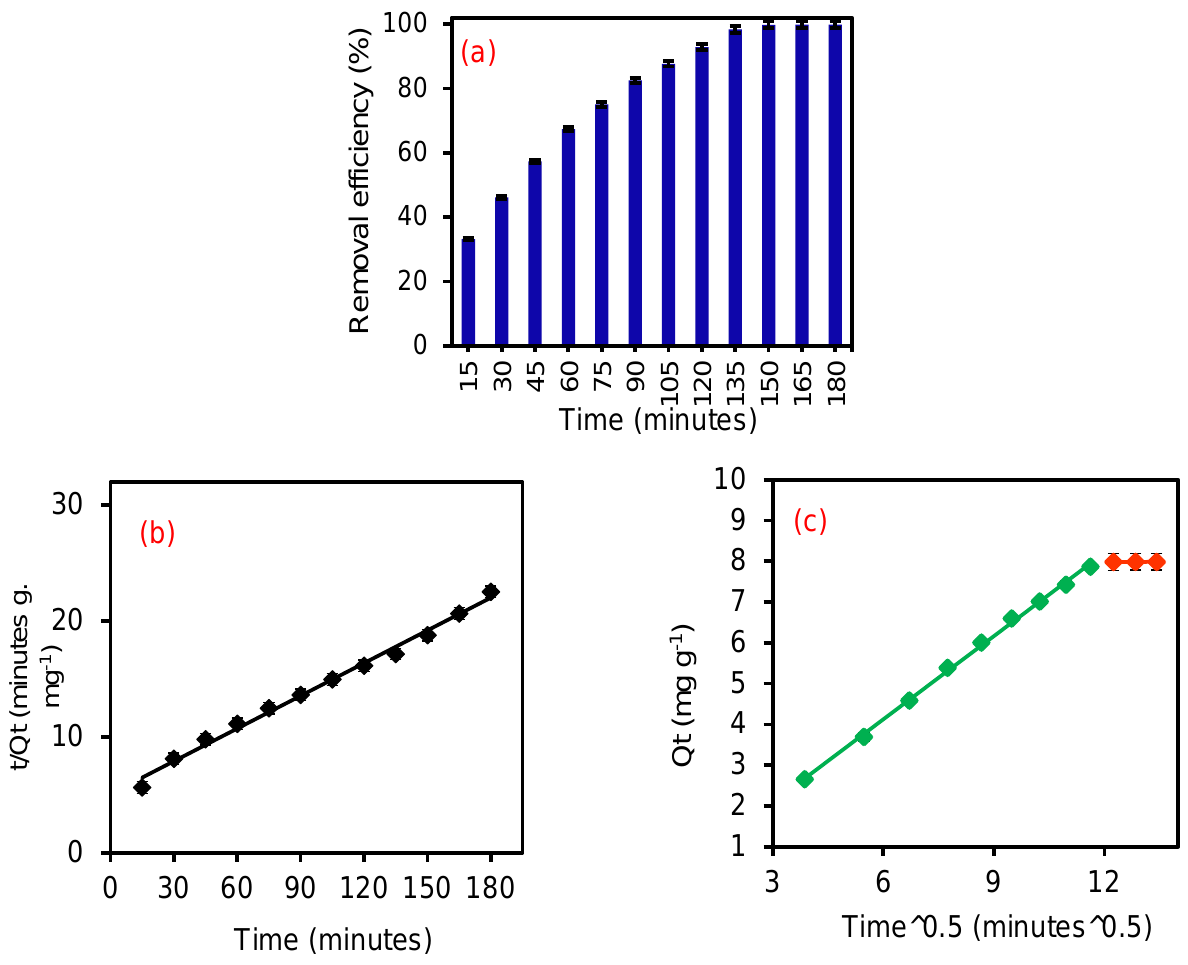
Figure 7. Plots of ( a ) contact time effect, ( b ) PSO kinetic model, and ( c ) WB model. (Experimental conditions: Adsorbent dose = 2.5 g L −1 ; Agitation speed = 200 rpm; Solution pH = 7; Temperature = 30 °C; Concentration 20 mg L −1 ).